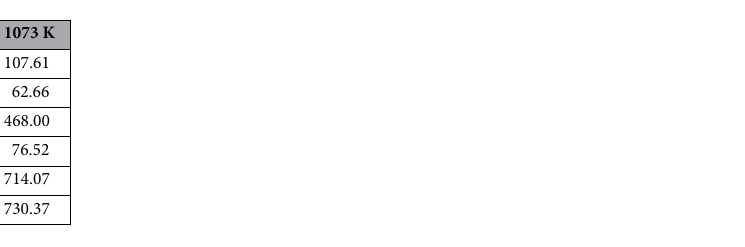
Table 5. Contribution of each strengthening mechanism to the initial yield strength of the CoCrFeMnNi specimens with different annealing temperatures (unit: MPa).